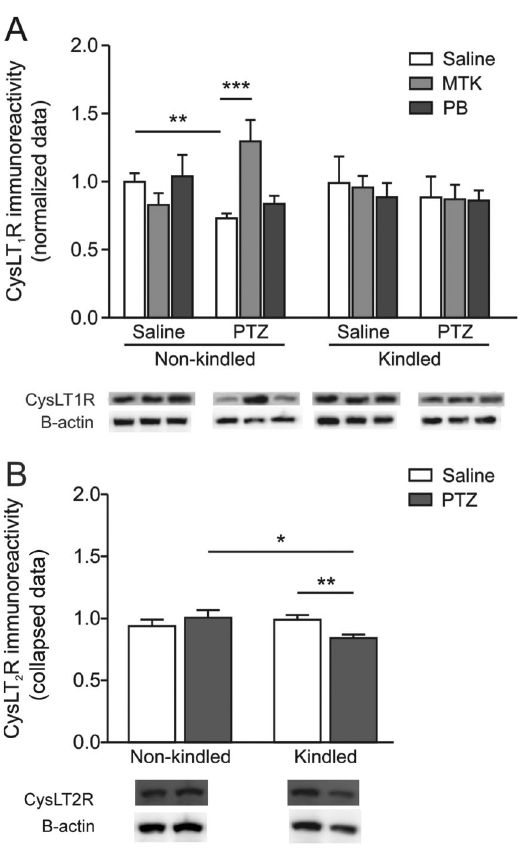
Figure 4. Effect of pentylenetetrazol (PTZ) kindling on CysLT 1 R ( A ) and CysLT 2 R ( B ) immunoreactivity in the cortex. Mice were treated with saline, montelukast (MTK) or phenobarbital (PB) and challenged or not with PTZ. Representative blots are